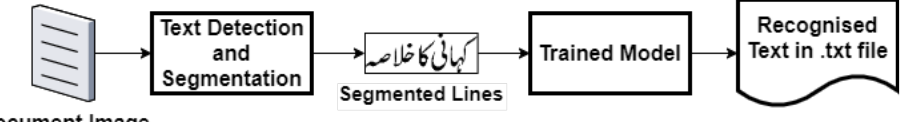
Figure 6. Proposed model data processing, input image to an output text